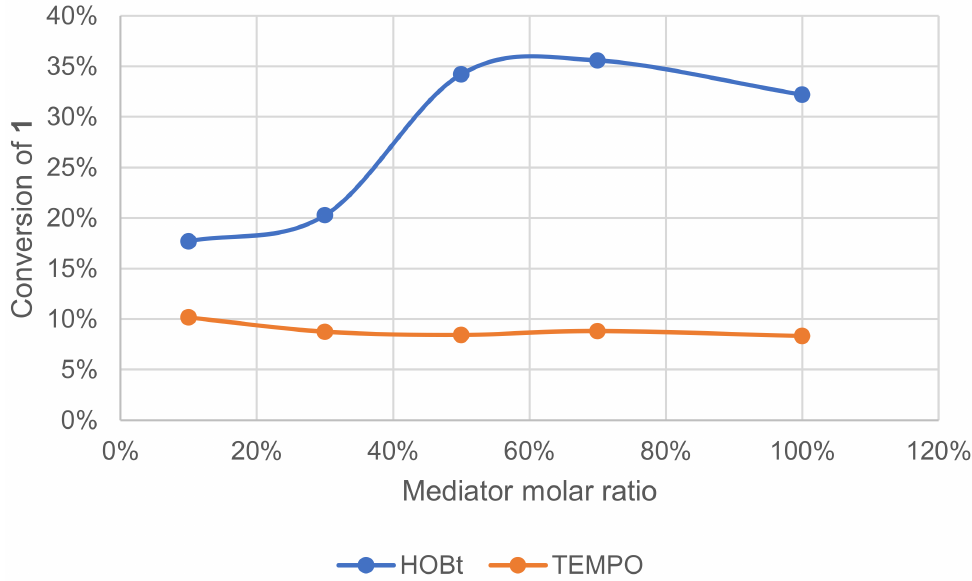
Figure 10. Effect of the mediator type and ratio on the conversion of 1 in the laccase-catalyzed oxidation (LA 10% w/w , mediator, acetate buffer pH5 0.25 M, O 2 atmosphere, incubation for 24 h, 40 ◦ C, 200